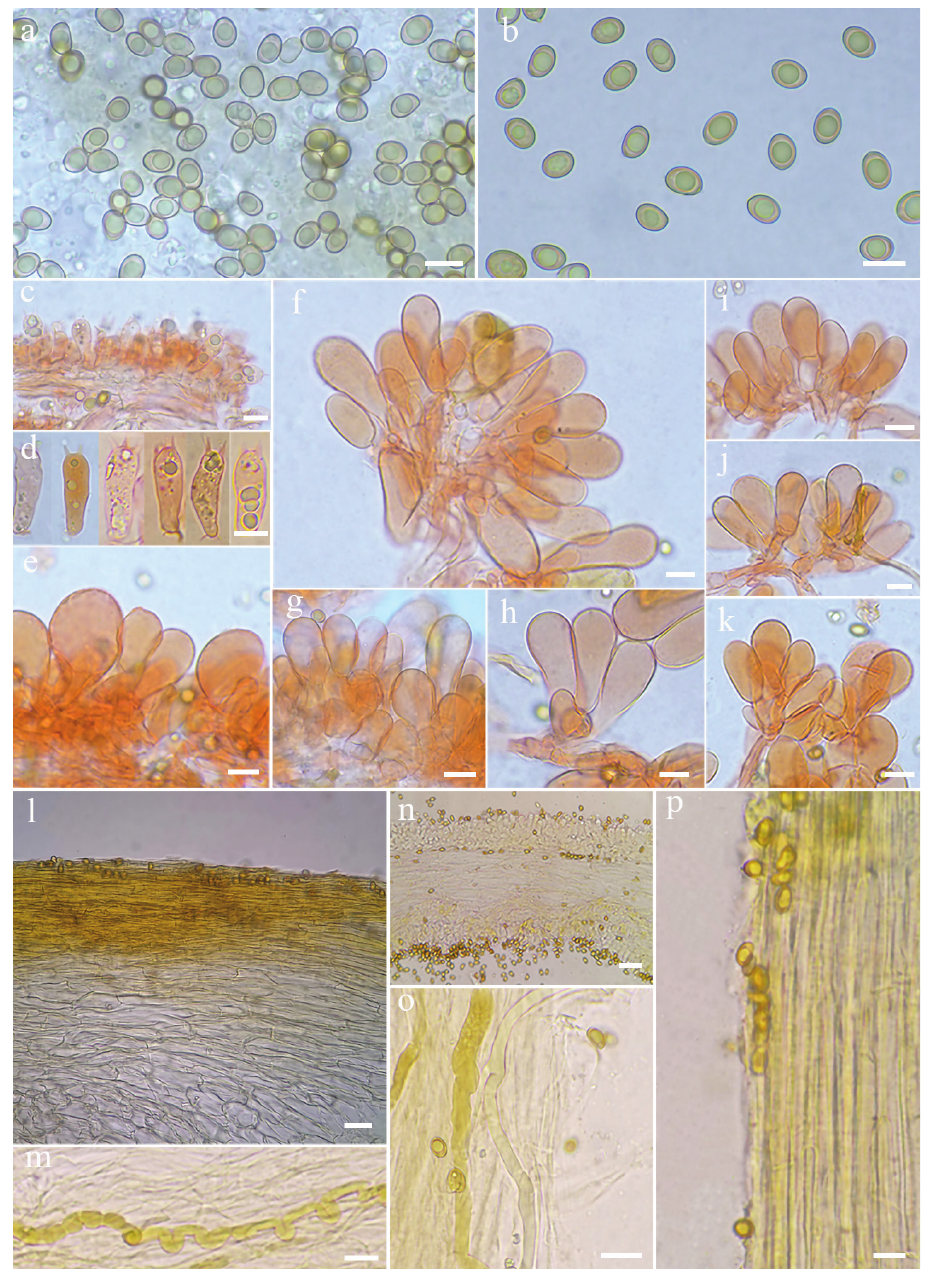
Figure 5. Microscopic features of Inosperma hainanense (FHMU3166, holotype) a–b basidiospores c–d basidia e–k cheilocystidia in clusters l pileipellis and pileal trama n hymenophoral trama m, o oleif- erous hyphae p stipitipellis and stipe trama. Scale bars: 10 μm ( a–k ). Photos by L.-S.